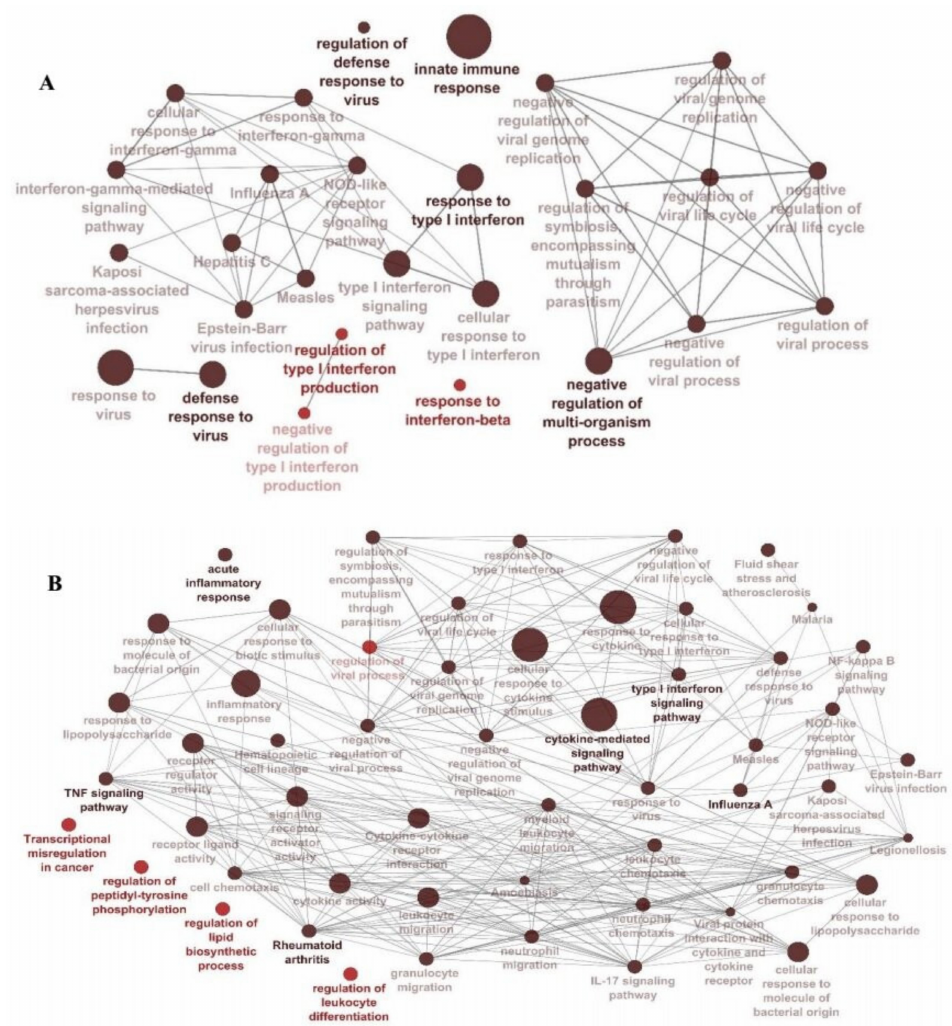
Figure 3. Biological processes and pathways detected within the ( A ) Turquoise module from the A549 dataset and ( B ) Yellow-green module from the NHBE dataset. Gene Ontology and pathway analysis was performed using significant genes across all datasets. Node size represents the counts (number of genes that are part of each pathway), and node color corresponds to the statistical significance. The darker the pathway node, the more statistically significant it is, with a gradient from red ( p -value 0.05–0.005) to black ( p -value <